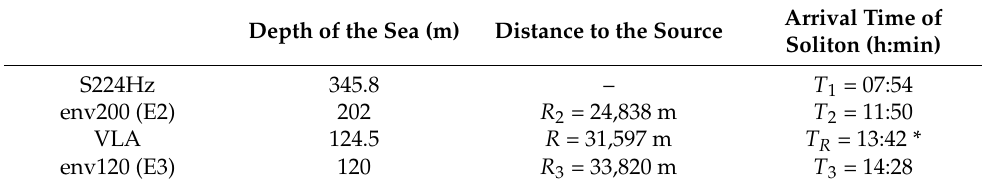
Table 1. Basic parameters of the experiment (13:42 *—calculated value). Depth of the Sea (m)